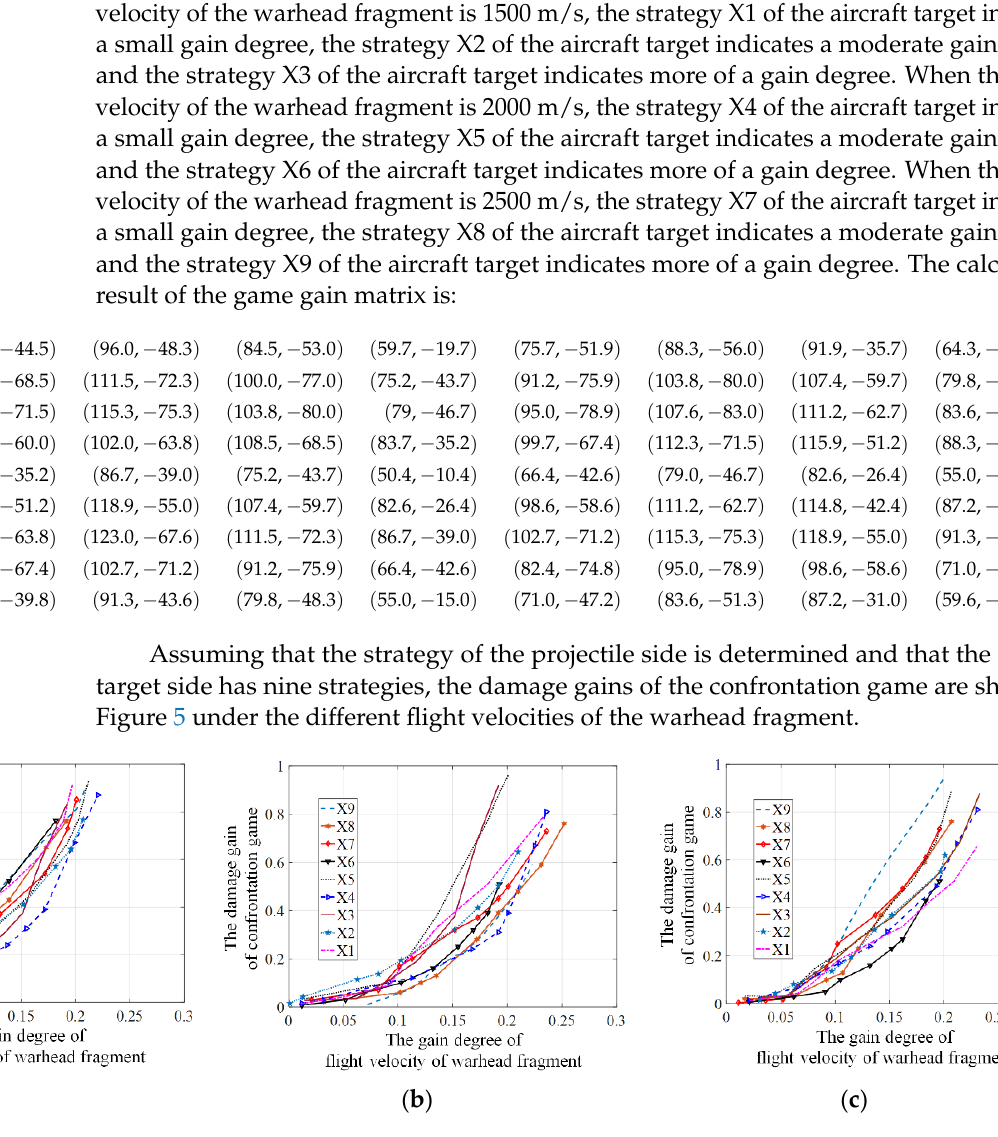
Table 2. The gain degree under different flight velocities of the warhead fragments. Gain Degree Strategic Factors Less Moderate More Flight velocities of the warhead fragments 1500 m/s 2500 m/s